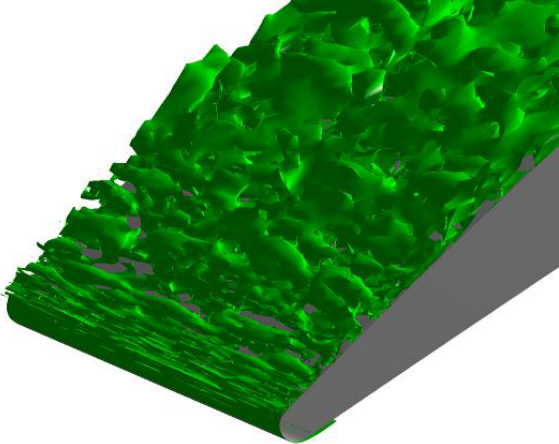
Figure 23. Iso-surface of the Q-criterion around the circular leading